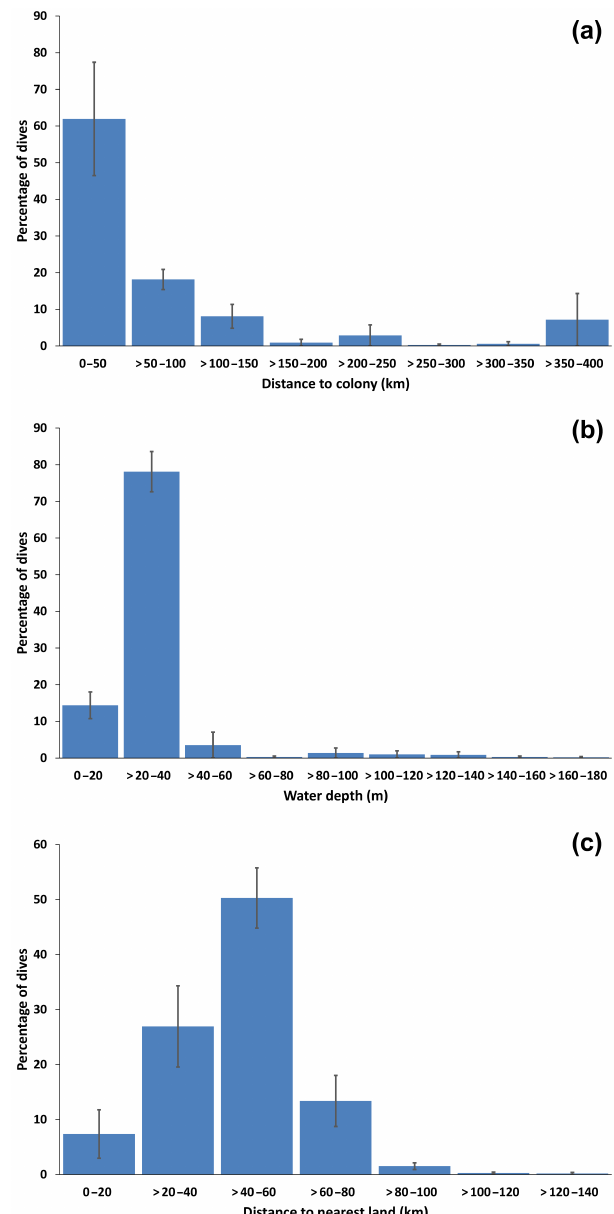
Figure 6. Habitat relationships (upper graph: distance to colony; middle graph: water depth; lower graph: distance to nearest land) of diving northern gannets in 2015. Data are based on 2557 dives recorded from four adults breeding on Heligoland. Vertical bars show mean values averaged over the four individuals; extended lines show standard